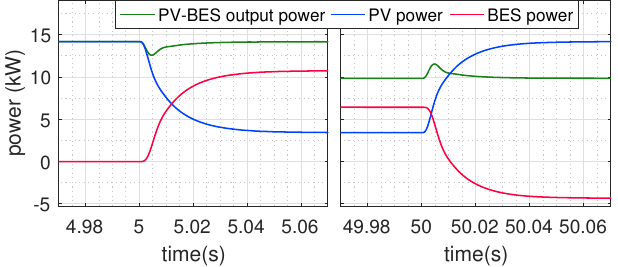
Figure 13. Power transients of the PV-BES system to PV disturbances.